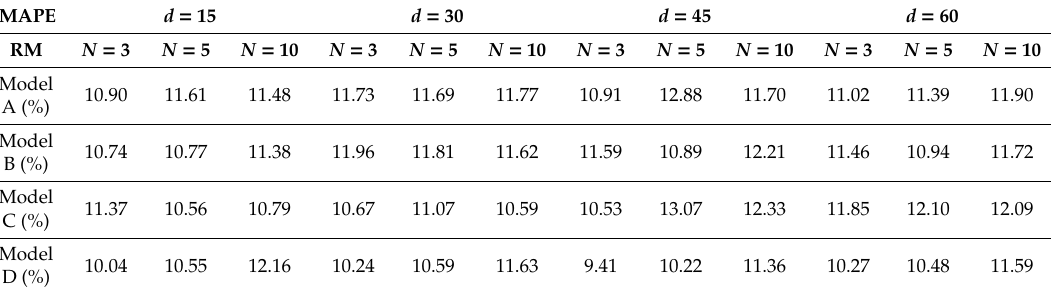
Table 3. Five-day average MAPE analysis (Regression